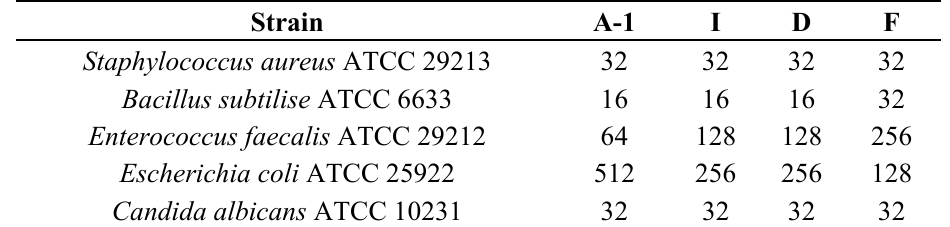
Table 2. Assay 3: MICs in μg mL − 1 of the halogenated derivatives of β -methyl- β